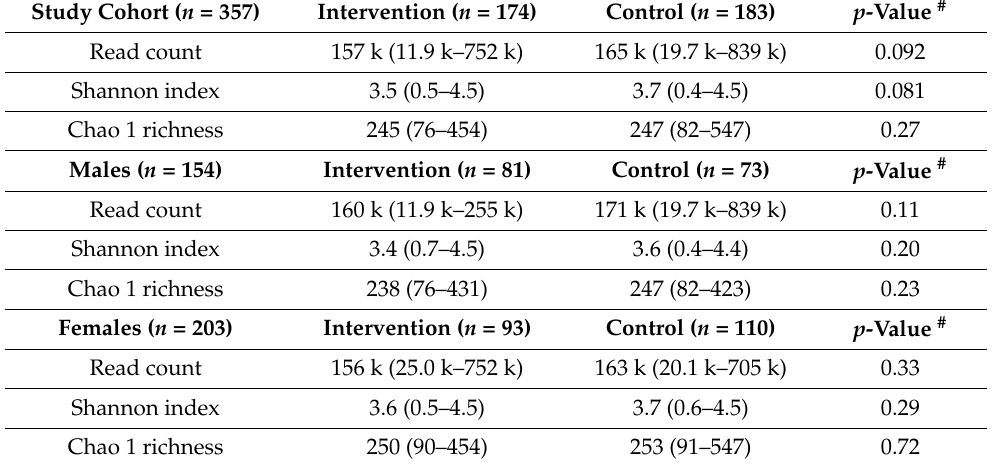
Table 2. Gut microbiota alpha diversity; values are median